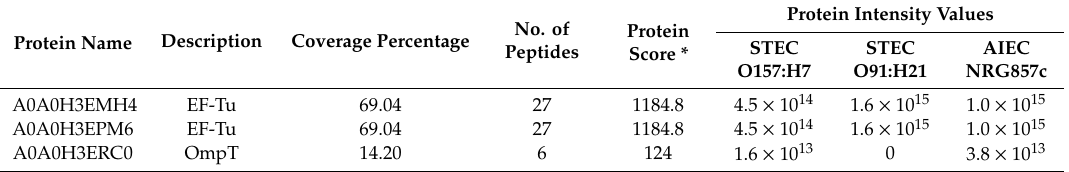
Figure 3. Immunogold electron microscopy showing detection of L -asparaginase II on the surface of STEC O157:H7 str. EDL933. Bacteria were incubated with anti- L -asparaginase II (1:200) followed by anti-rabbit IgG+IgM (1:100) 20 nm gold particles. ( A , B ) Localization of L -asparaginase II on the surface of the EDL933 strain. The localization of L -asparaginase II on the cell surface was demonstrated by abundant labeling with gold particles (Arrows). ( C , D ) Image obtained from the EDL933 ∆ asnB strain . Note that in this case, a few gold labels were observed, but they appear to correspond to background noise rather than a specific detection. Table 2. Identification of EF-Tu and OmpT proteins in outer membrane vesicles purified from Shiga toxin-producing Escherichia coli (STEC) O157:H7, STEC O91:H21 and AIEC NRG857c, by UPLC-MS/MS.